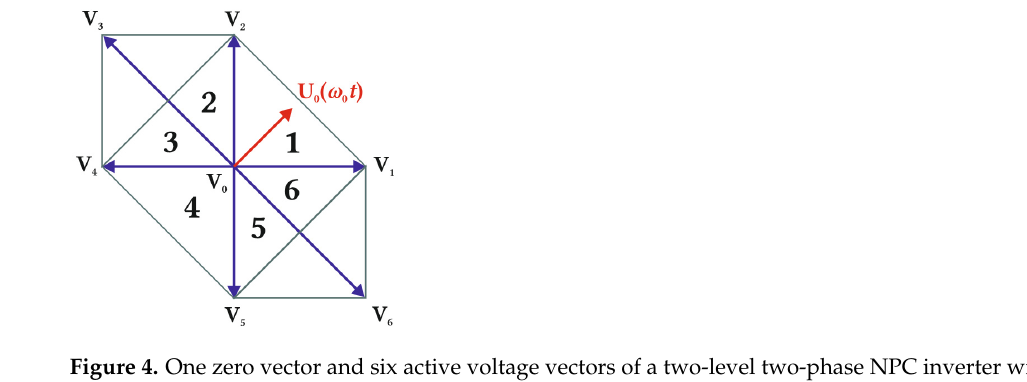
Figure 4. One zero vector and six active voltage vectors of a two-level two-phase NPC inverter with three legs. U 0 represents the rotating magnetic field and is used as a reference voltage vector. U 0 is synthesized by the proper sequence of V 0 , V 1 , and V 2 vectors. The vectors create a hexagon that is divided into six sectors. Table 2. Equations for t 1 and t 2 for every sector of two-level hexagon. ϑ is the angle, and ρ is the magnitude of U 0 vector in polar coordinates.